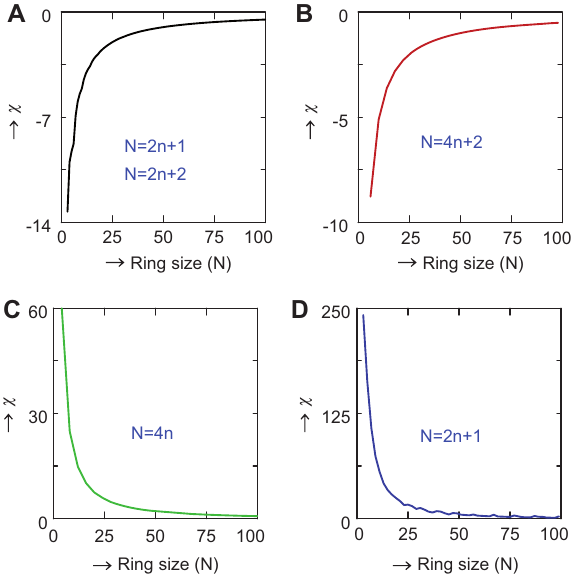
Figure 7 Low-fi eld magnetic susceptibility as a function of system size N for single-channel mesoscopic rings in half-fi lled case. (A) U = 0. N is an odd (2 n + 1) or an even (2 n + 2) number, where n is an integer. (B) U = 1. N is an even number obeying the relation N = 4 n + 2. (C) U = 1. N is an even number satisfying the relation N = 4 n . (D) U = 1. N is an odd number following the relation N = 2 n +